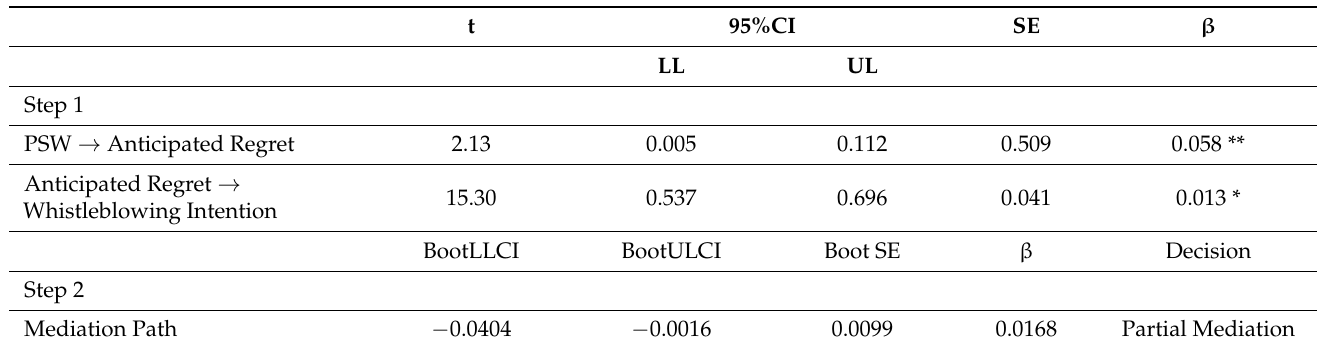
Table 5. Mediation